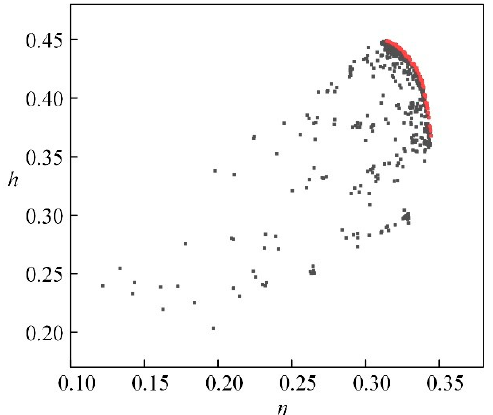
Figure 11. Optimization results of the NSGA-II algorithm.